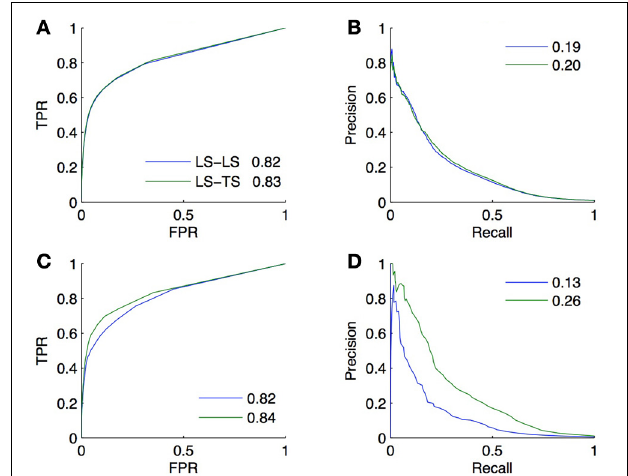
FIGURE 9 | Comparison of the CV estimates of the LS × LS and LS × TS scores, ROC curve in (A) and PR curve in (B), with true score values for the same two families of predictions, ROC curve in (C) and PR curve in (D), when only positive and unlabeled pairs are available. AUROC and AUPR values are found in the